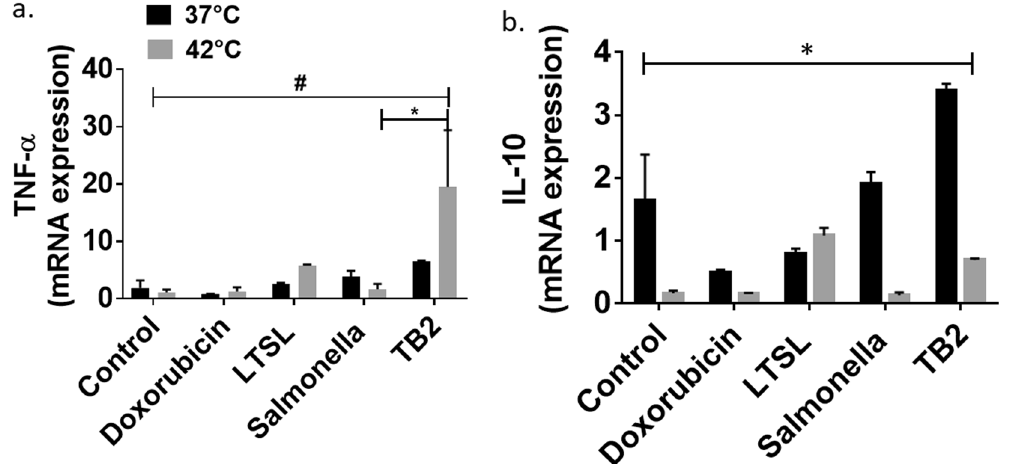
Figure 3. Impact of TB/heat treated C26 condition media on RAW264.5 macrophage cytokine gene by qRT-PCR. ( a ) TB plus 42 °C achieved significantly higher TNF- α gene expression compared to controls, dox and LTSL treatment at 37 °C and 42 °C; ( b ) Significant drop in IL 10 expression at 42 °C compared to body temperature was noted for all treatments. Values represent means ± SE (n = 3) for each treatment, #, * p <